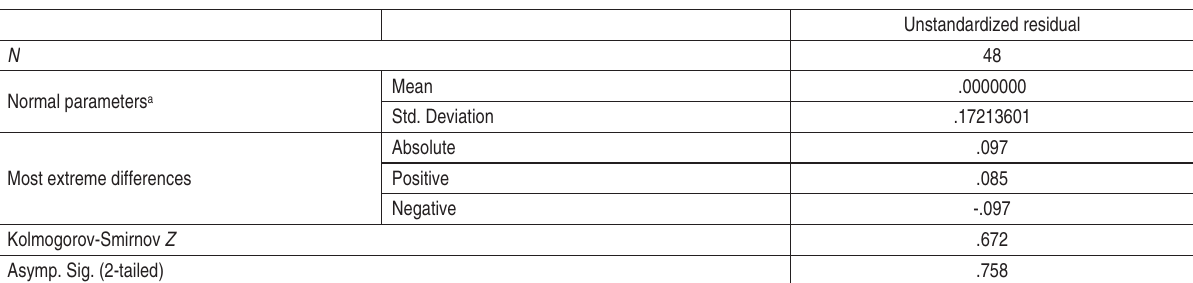
Fig. 1. Normality test with p -plot chart Table 2. Normality test with KS